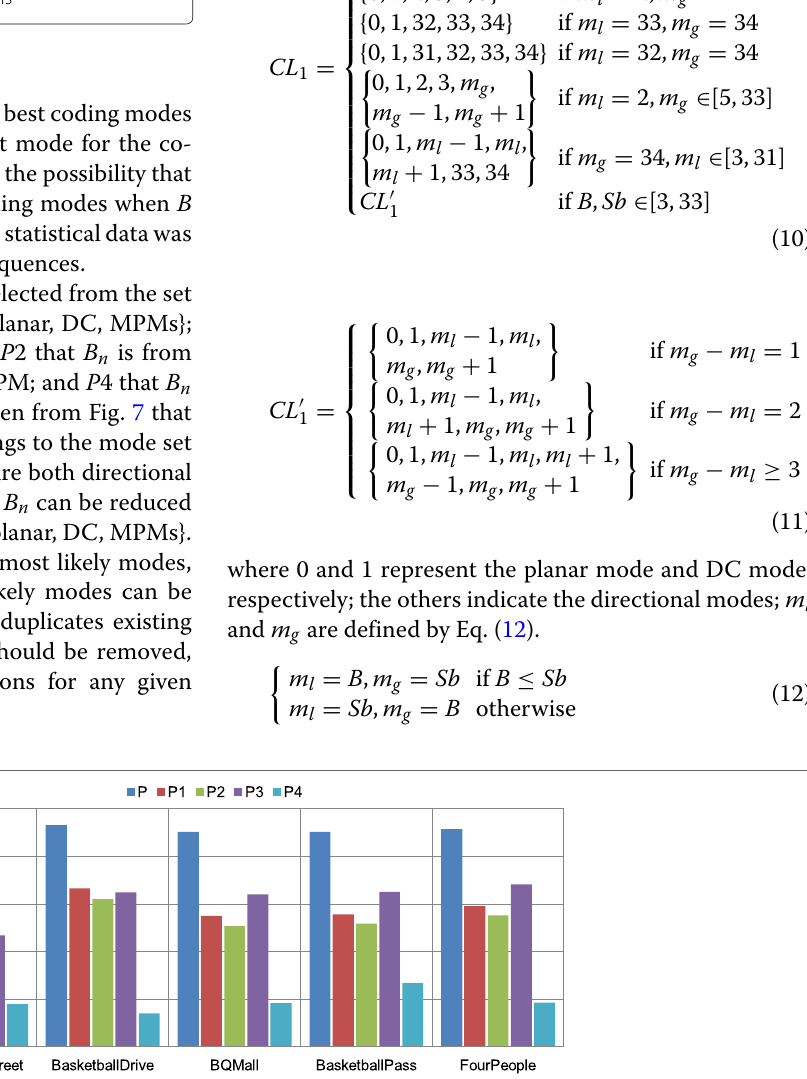
Fig. 6 PU modes at adjacent coding depth levels